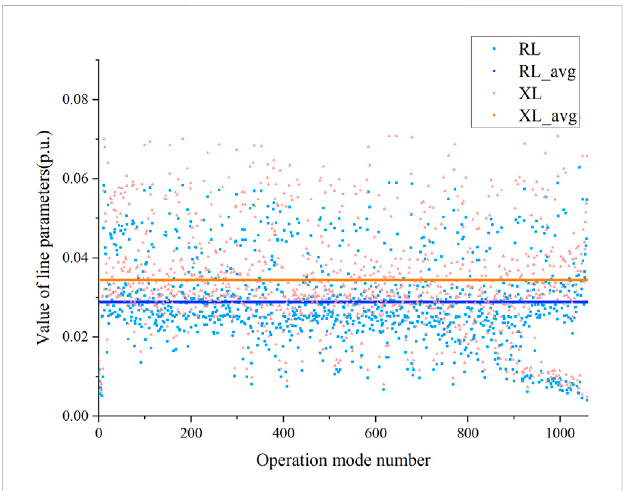
The RMSE calculated by substituting the parameter averages into the equivalent